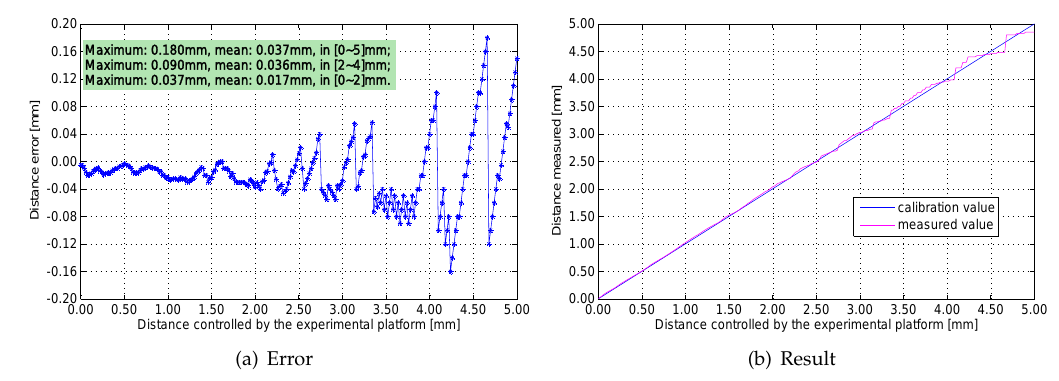
Figure 19. Measurement errors and results at 110 ◦